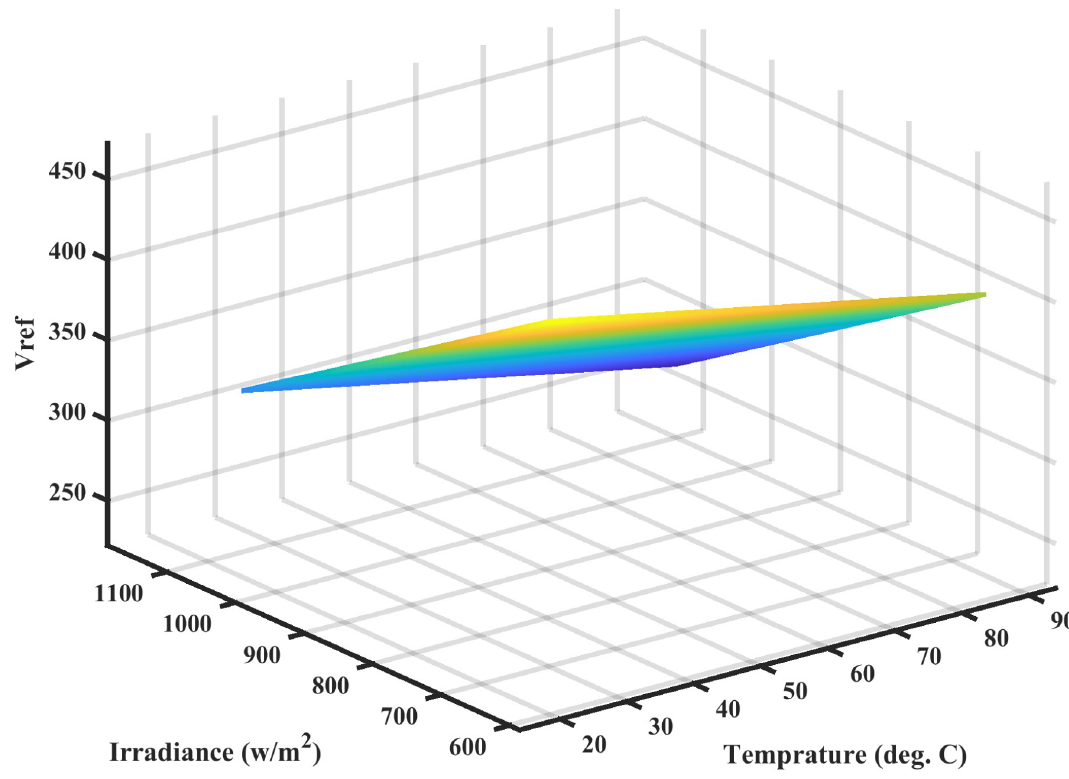
Fig 8. V ref for different values of irradiance and